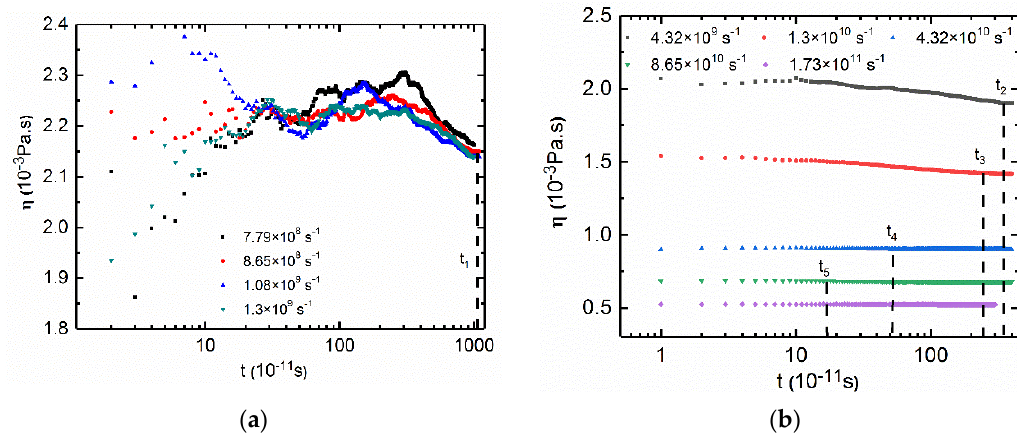
Figure 8 . The “plateau” time of different shear rates. ( a ) “plateau” time of low shear rates; ( b ) “plateau” time of medium and high shear rates. C CTAC = 0.3 mol · L − 1 , C PAM = 2.96 × 10 − 3 mol · L − 1 .